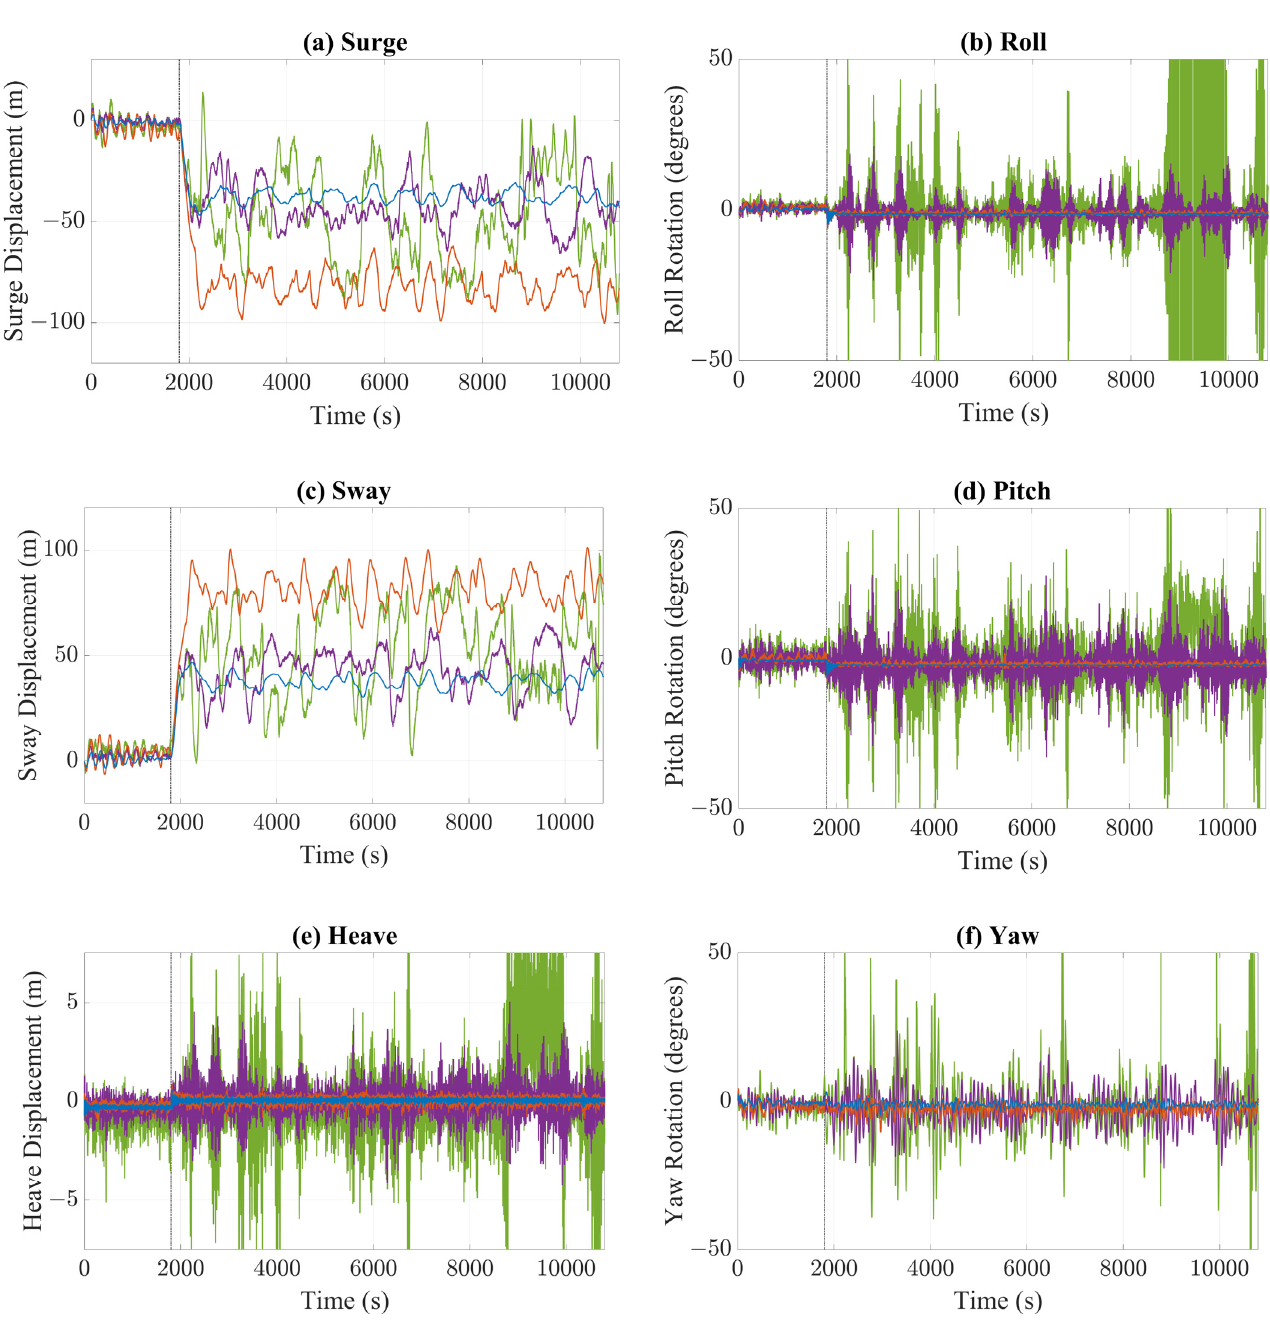
Figure 16. Motions of the moored FOWC device in ( a ) surge, ( b ) roll, ( c ) sway, ( d ) pitch, ( e ) heave, and ( f ) yaw following the simulated failure of Line 4 at 1800 s.